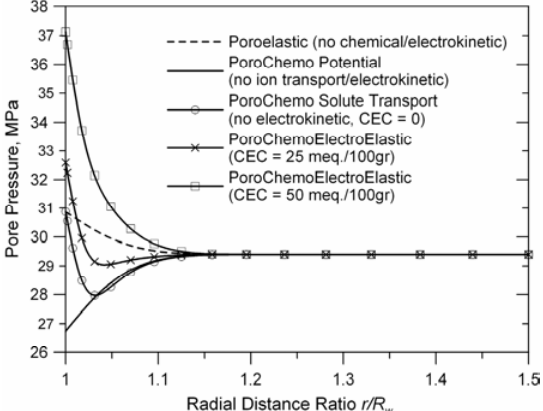
Fig. 13 – Pore pressure distribution in the formation after t = 15 minutes at different CEC values for low mud activity (high mud f . 87 < a f . salinity): a o = 0 mud = 0